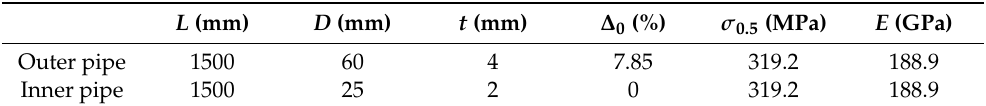
Table 1. Geometrical parameters and physical properties of the pipe in the model experiment; the data are from [15].